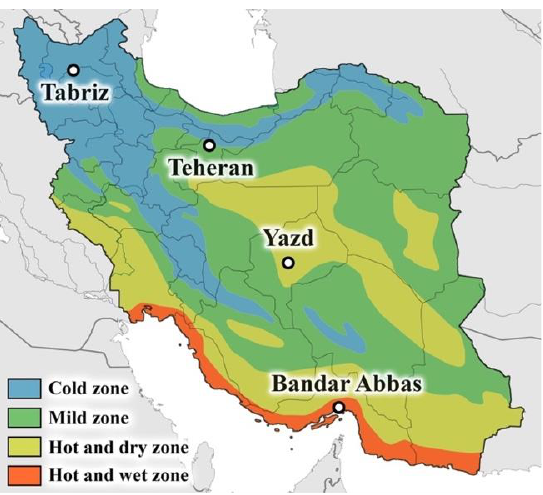
Figure 2. Climatic zones in Iran and the location of the four